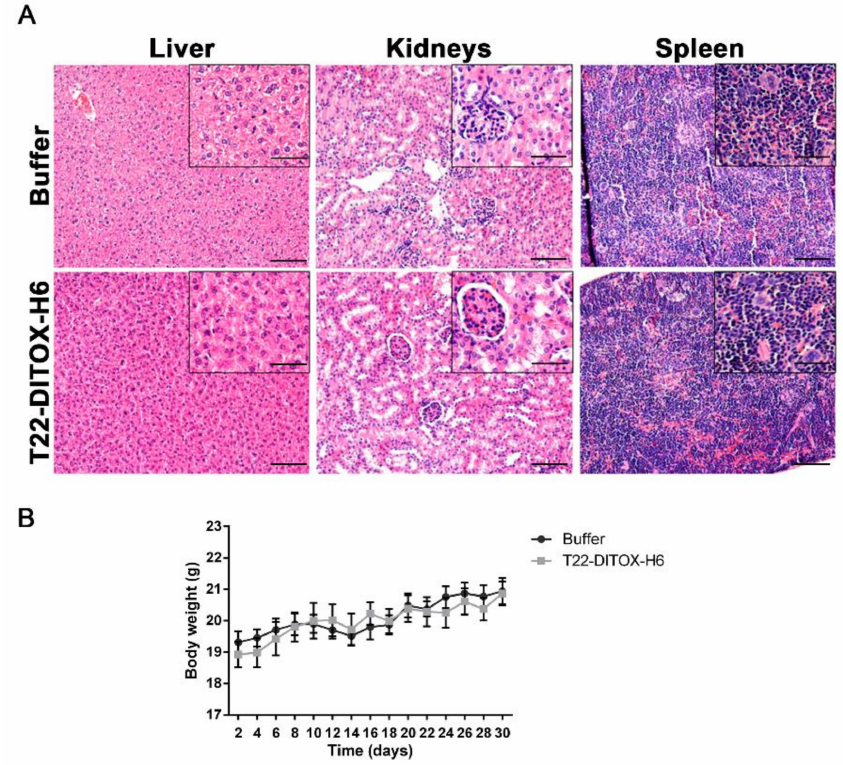
Figure 5. Evaluation of the systemic toxicity derived from T22-DITOX-H6 administration in the HNSCC-disseminated mouse model. ( A ) Histopathological analysis by H&E staining in liver, kidneys, and spleen samples collected from buffer- and T22-DITOX-H6-treated groups. Scale bars = 100 µ m and 50 µ m (zoom in) ( B ) Body weights of buffer- and nanotoxin-treated animals over the course of the experiment. Error bars indicate